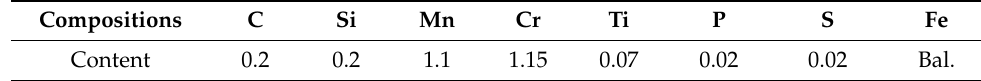
Table 1. Chemical composition of 20CrMnTiH steel (wt.%). Figure 5. CCT curves and cooling curves of 20CrMnTiH steel. ( a ) CCT curves of 20CrMnTiH steel; ( b ) cooling curves of 20CrMnTiH steel when martensitic and bainitic transformations can be obtained.